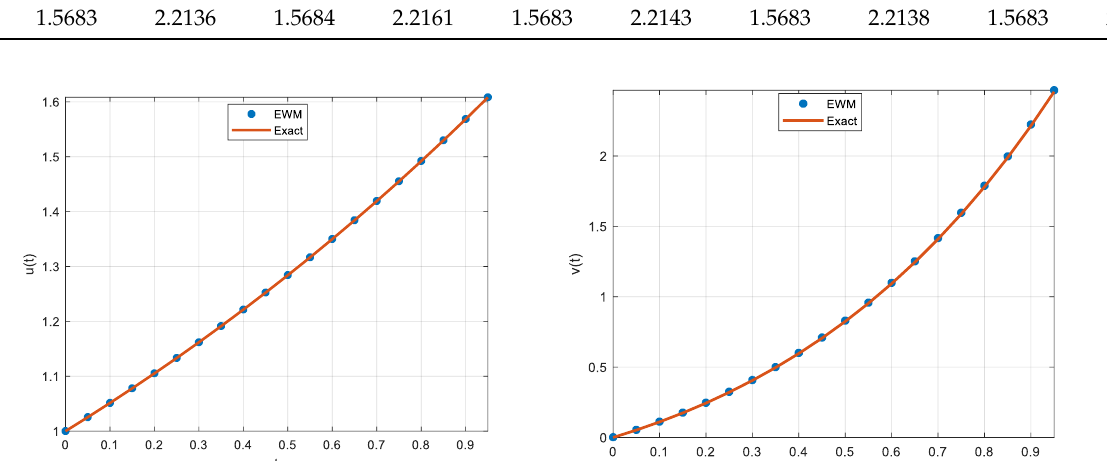
Figure 5. Numerical and exact solutions of u ( t ) and v ( t ) for α = 1, β = 1 for Example 3 ( m (cid:48) = 12).